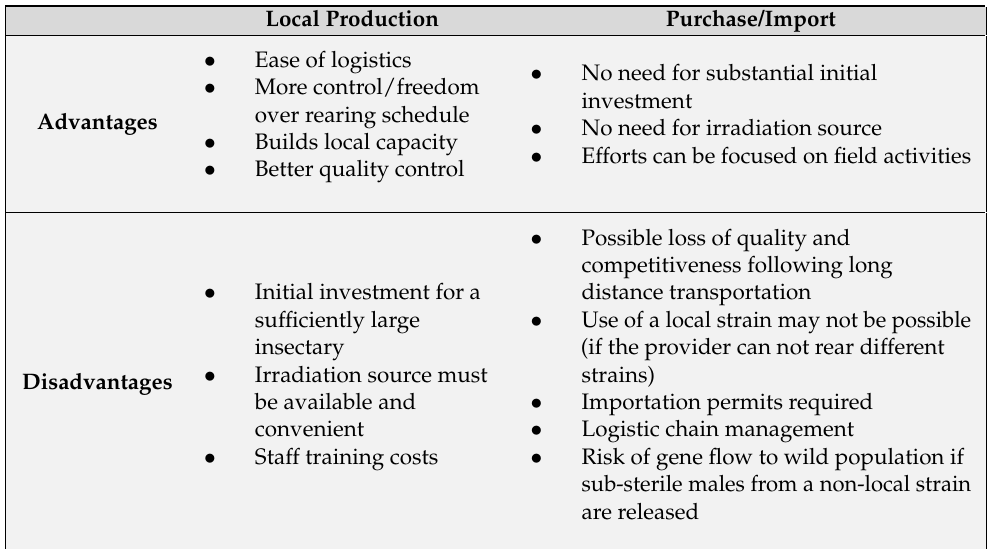
Table 4. Advantages and disadvantages of local production and importation of sterile males for sustaining a sterile insect technique (SIT) pilot trial for vector mosquito